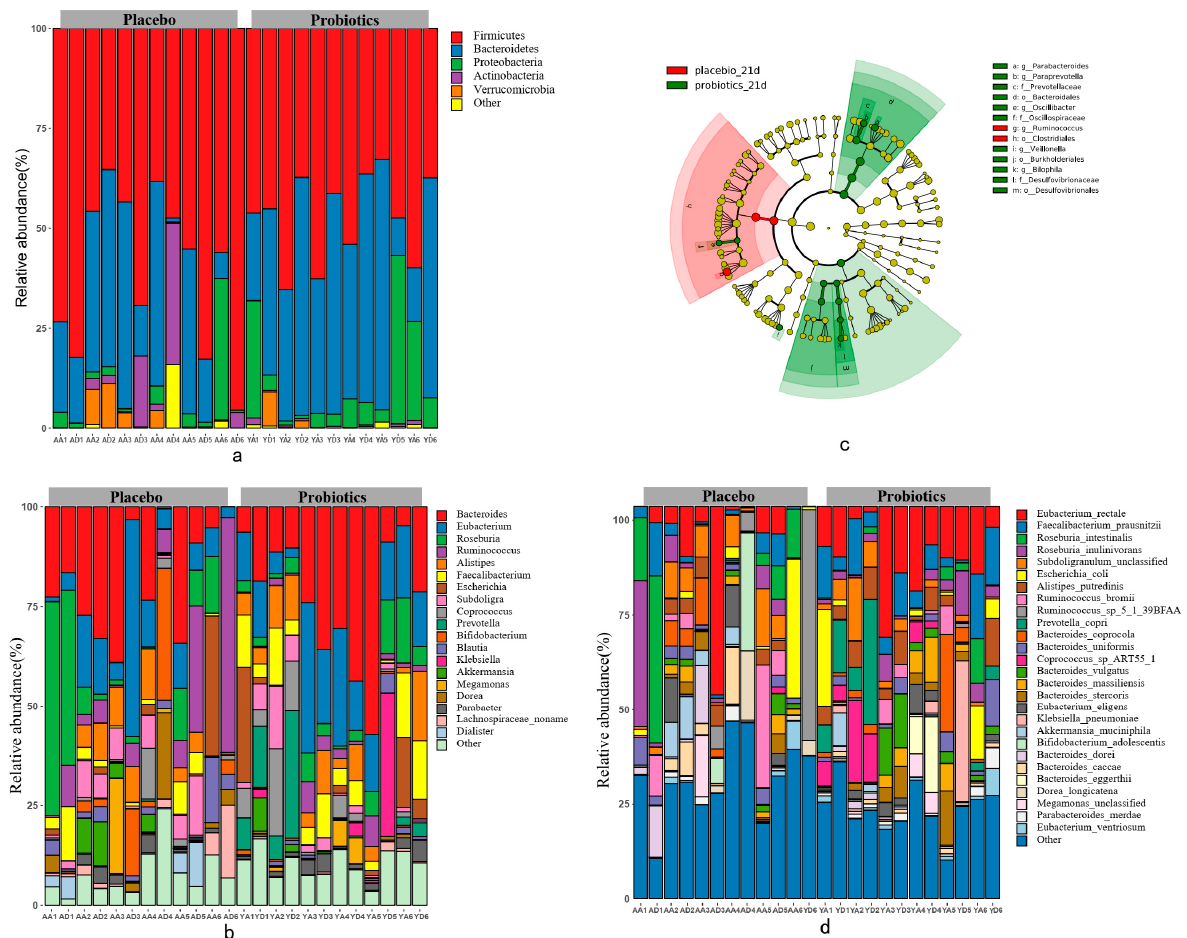
Figure 3. The gut bacterial composition of the volunteers. ( a ) The bar chart of the relative phylum abundance exceeding 1%; ( b ) The bar of the relative genus abundance exceeding 1%; ( c ) 21 d LefSe genus analysis; ( d ) The bar of the relative species abundance exceeding 1%.